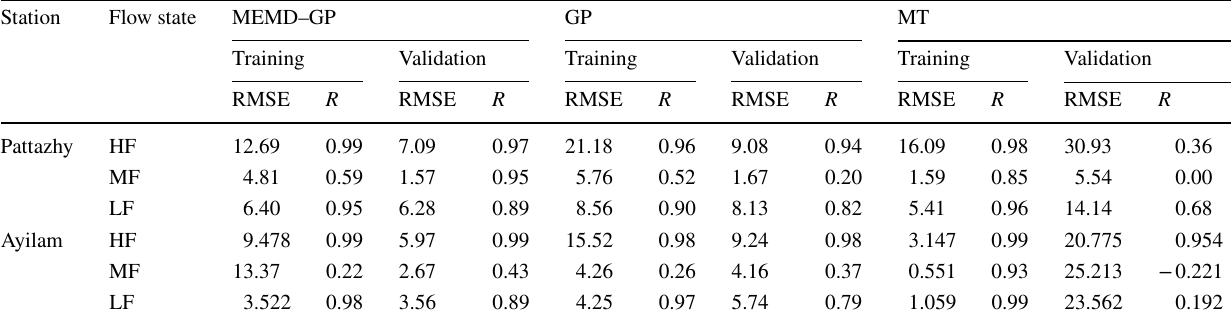
Table 5 Performance evaluation of high, low and medium states of daily discharge predictions using different methods